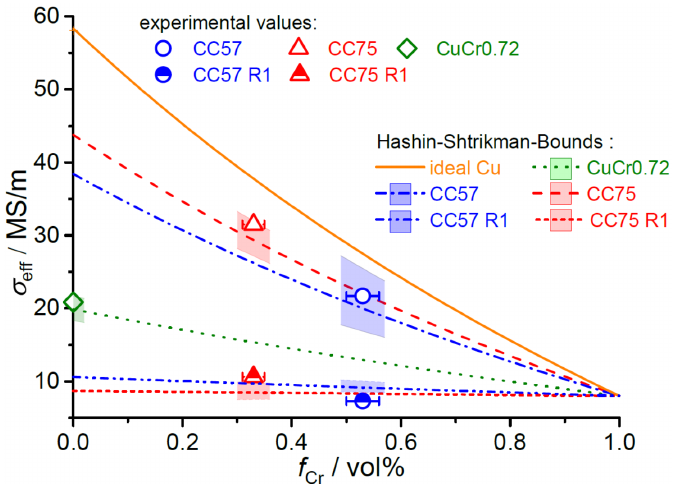
Figure 7. Comparison of experimentally observed and calculated electrical conductivities. Calculated σ eff with σ Cu = 8 MS/m and σ ( Cu) according to Table 3. Errors of experimentally determined σ are below the symbol size.